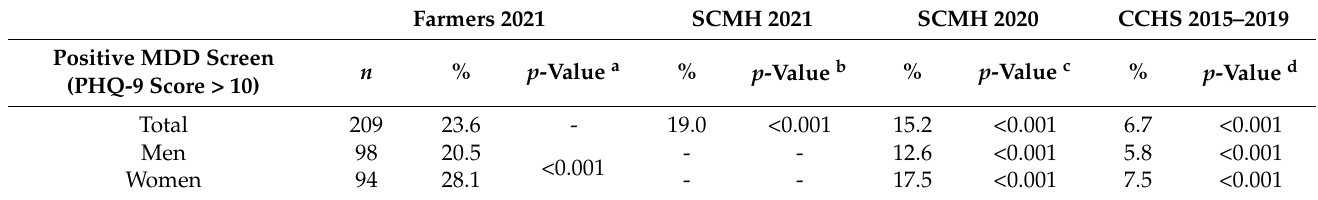
a Statistical comparison within 2021 data. b Statistical comparison of 2021 data with Canadian general population in Spring 2021. c Statistical comparison of 2021 data with Canadian general population in Fall 2020. d Statistical comparison of 2021 data with Canadian general population between 2015 and